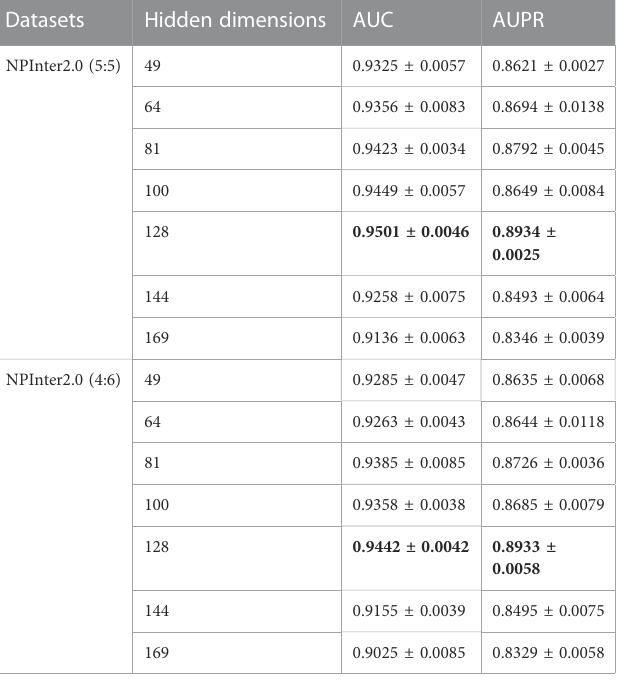
TABLE 7 Performance and standard deviation with seven different hidden dimensions. Datasets